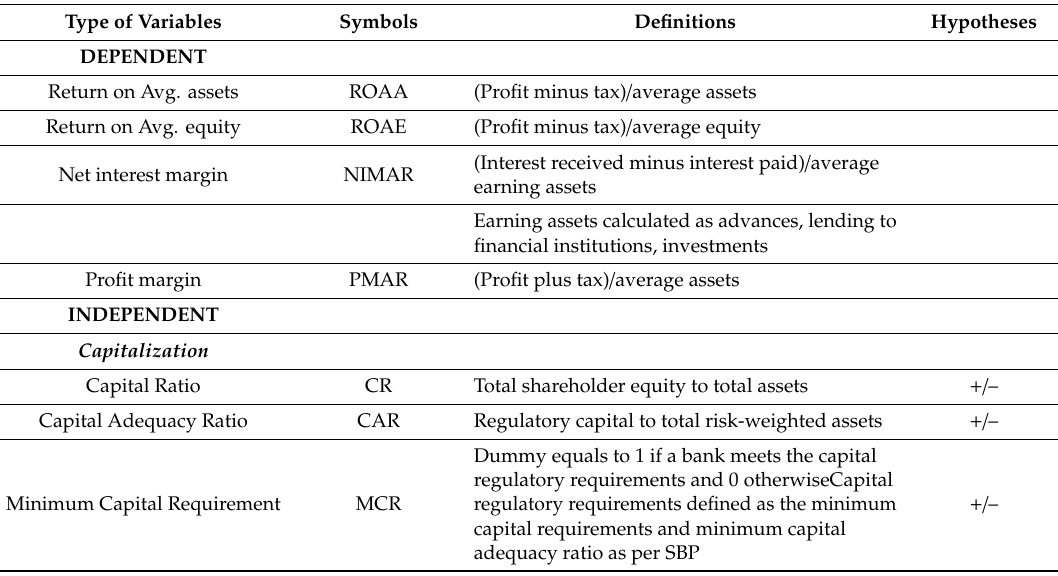
Table 2. Variables of the study with their